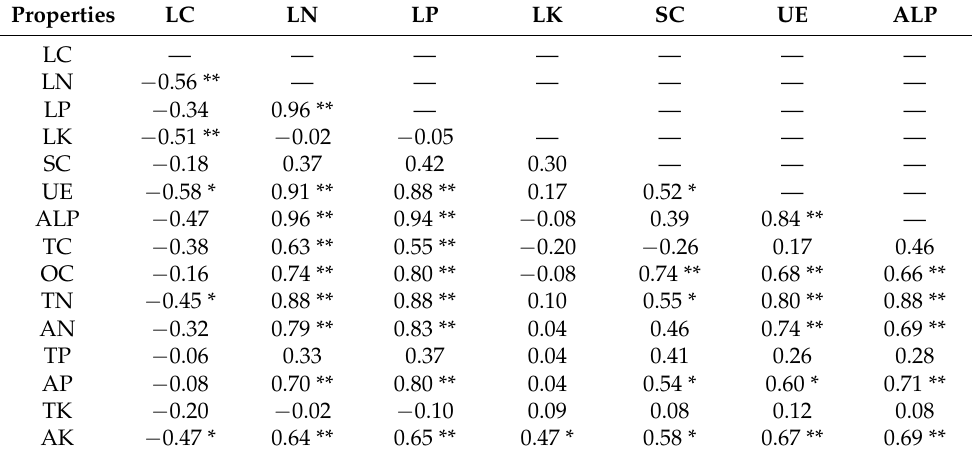
Table 3. Correlation coefficients of chemical litter properties, soil enzyme activities, and soil nutrients in